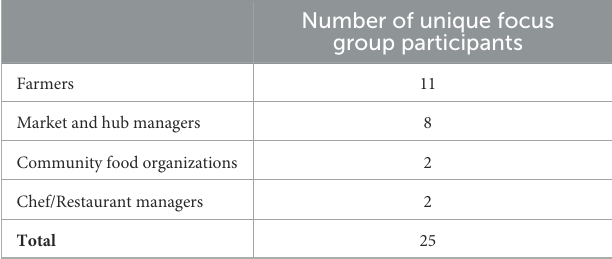
TABLE 1 Overview of focus group